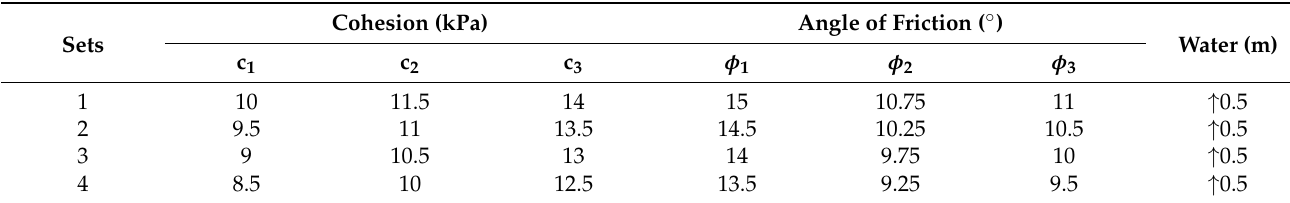
Table 4. Four sets of parameters for simulating the slope deformation.